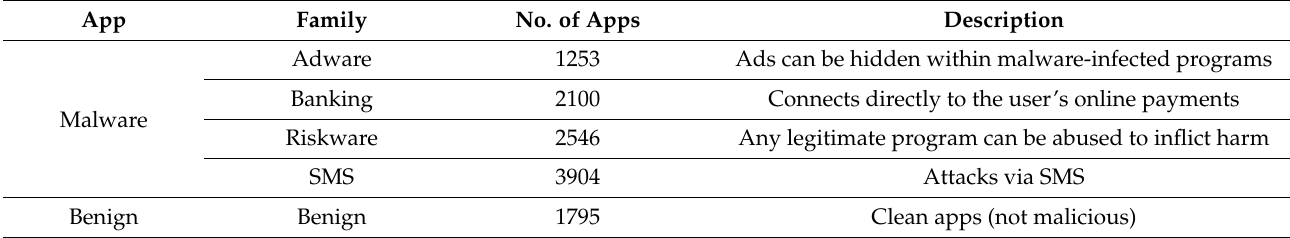
Table 3. CICMalDroid 2020 dataset (dataset